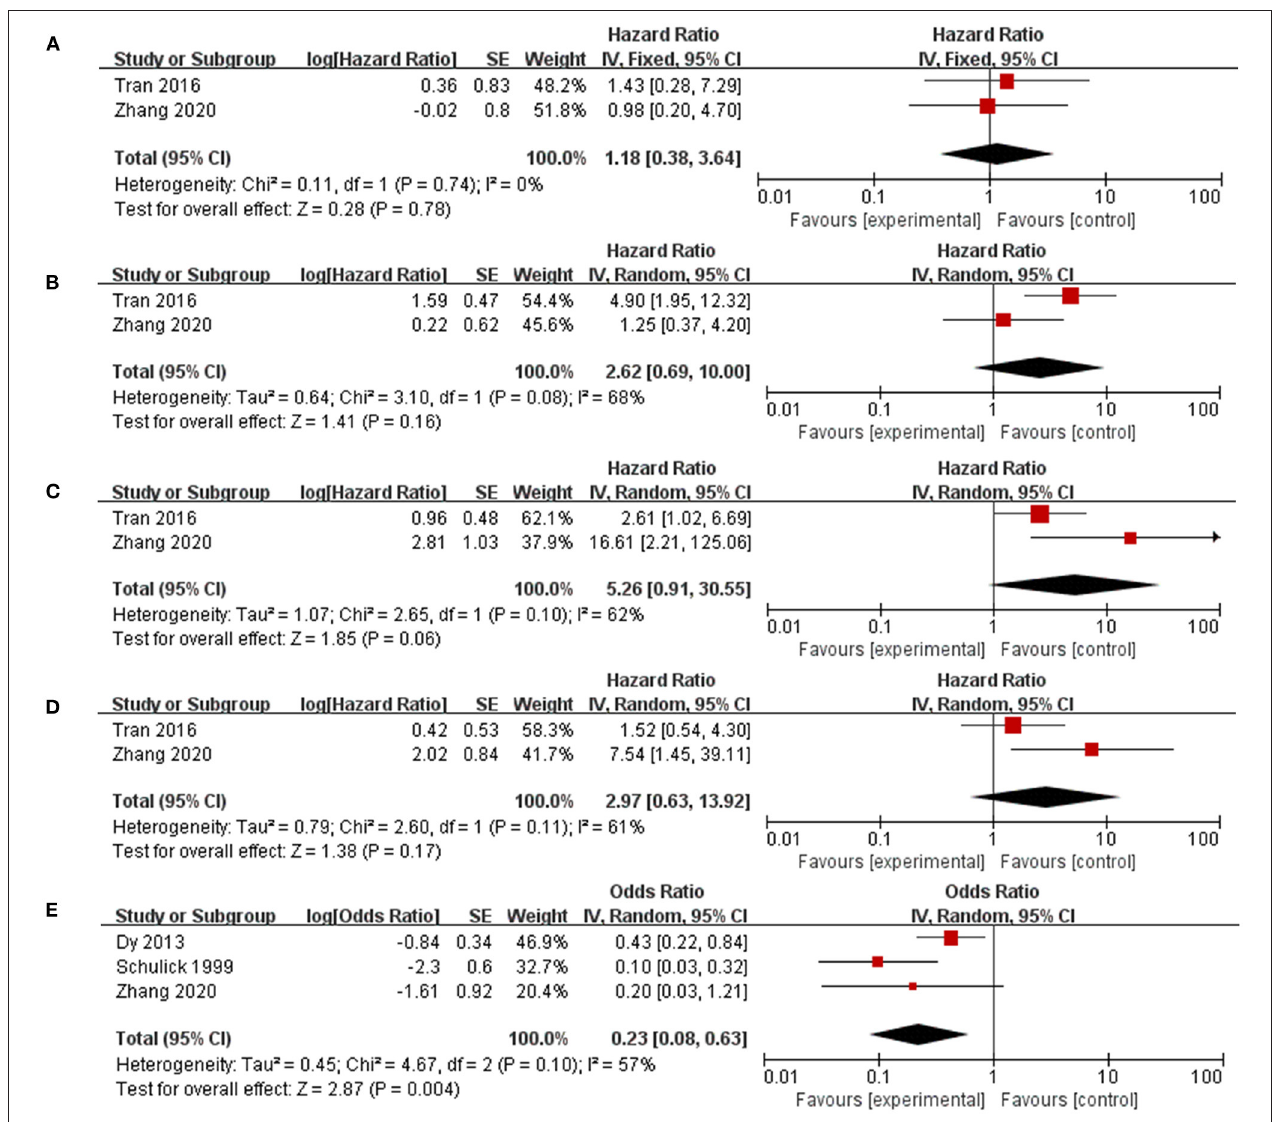
FIGURE 4 | Factors that identify patients who benefit more from reoperation. (A) Relatively high Ki67 index; (B) Multiple recurrence; (C) Disease-free interval < 12 months; (D) Initial R0 resection; (E) Complete resection of recurrent